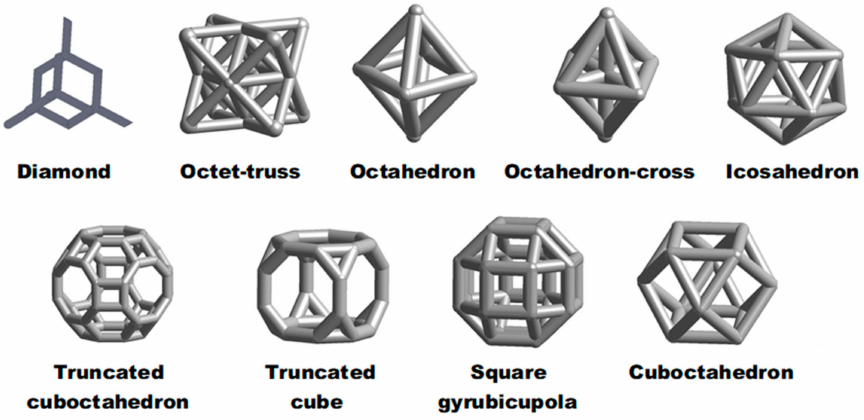
Figure 10. Representative unit cells [49].